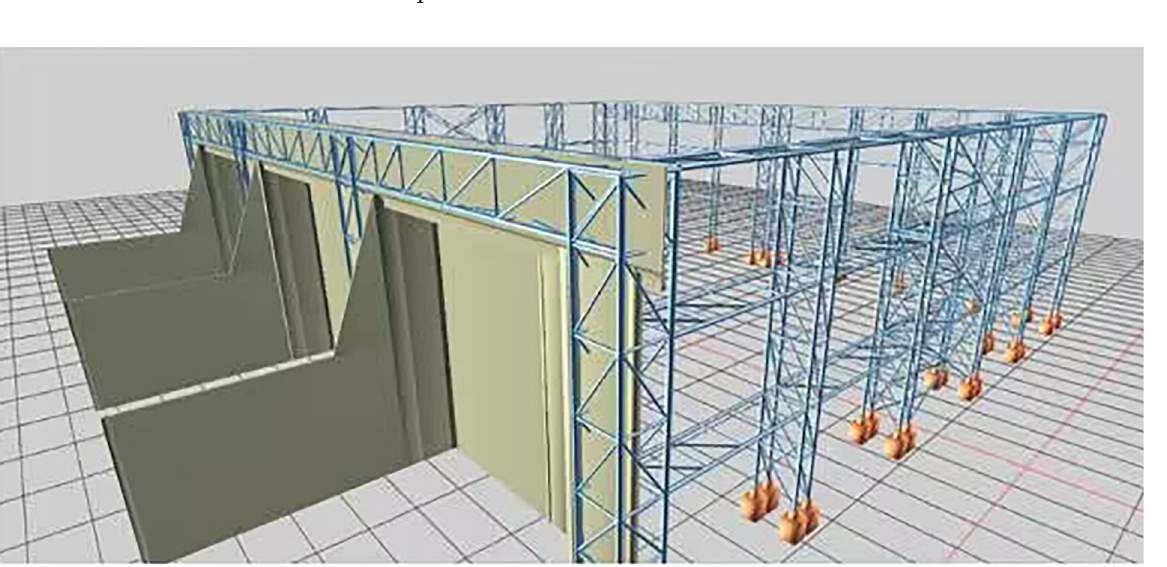
Figure 3. An intelligent real-time analysis system for the mechanical properties of members in the whole process of the hoisting of a large-span valve hall space grid.